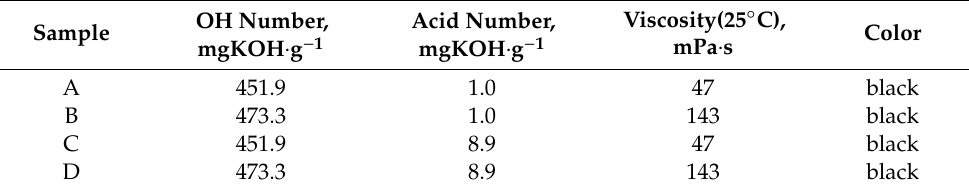
Table 1. Properties of bio-based